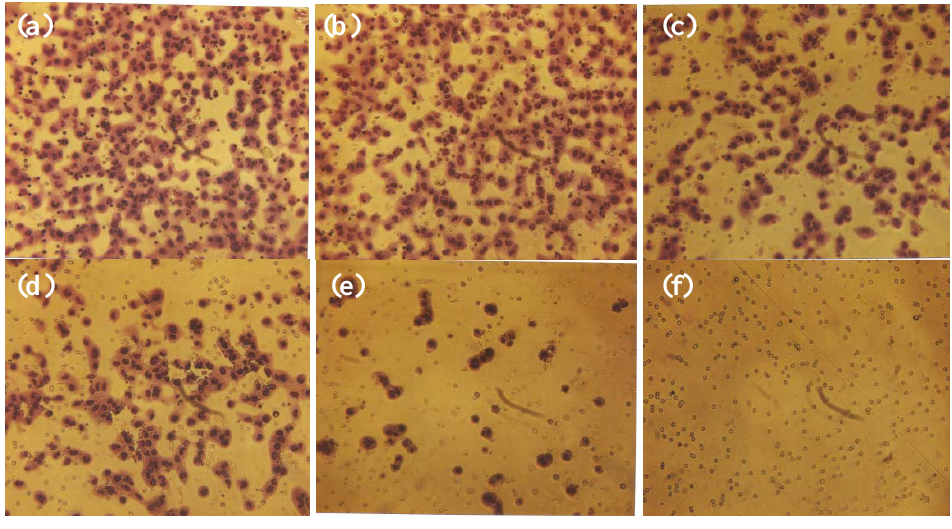
Figure 7. Effect of NM on HepG2 cell invasion through Matrigel: photomicrographs.